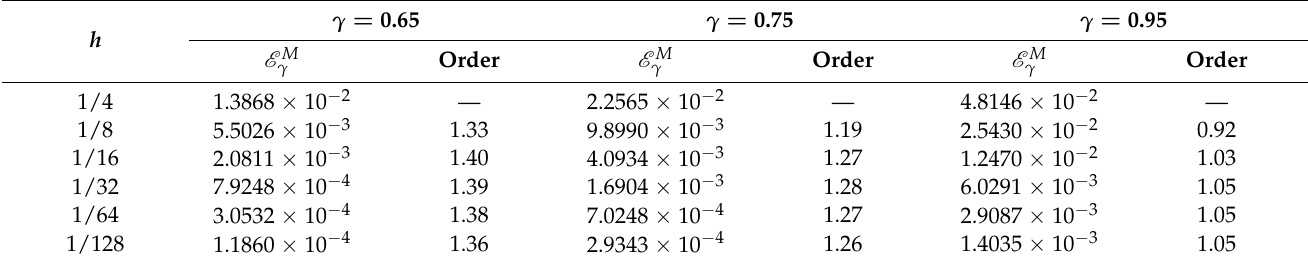
Table 4. E M γ and numerical convergence order in the spatial direction ( k = 1.25 × 10 − 6